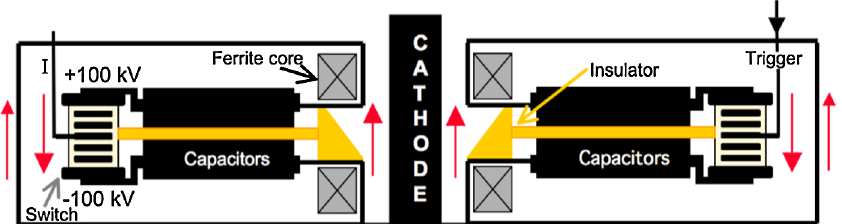
FIG. 3. (Color) Pictorial representation of a side section of the LTD cavity where the load now is the coaxial line formed by the inner cylindrical surface of the cavity and the central (cathode) cylindrical electrode (at this representation double-ended capacitors are assumed). The red arrows show the current direction in each